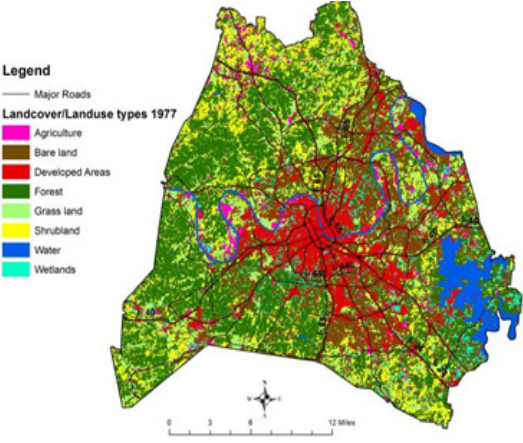
Table 1: Generated Error Matrix Table for Land cover/Land use classification of 2016 Land cover/ land use classes Grassland